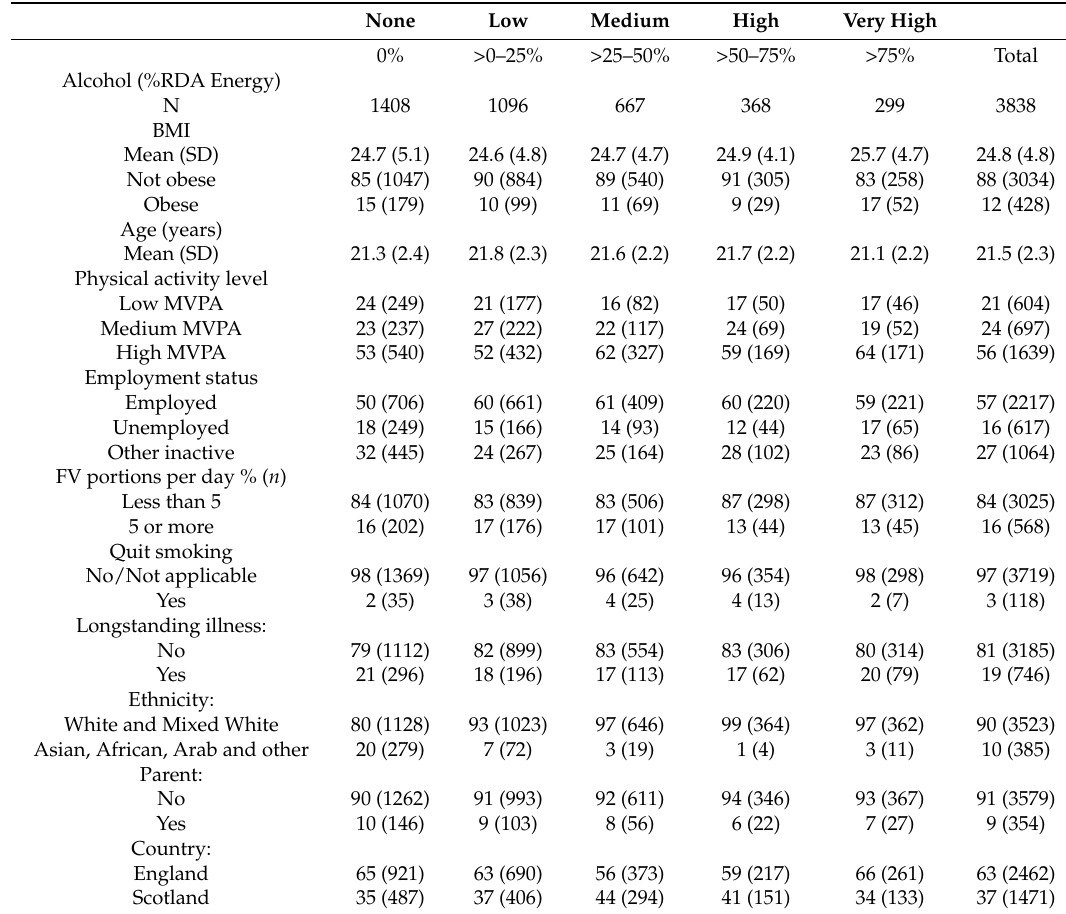
Table 3. Characteristics of the sample from the combined 2008–2014 HSE and SHS survey, by percentage of recommended daily allowance for energy from alcoholic beverages consumed by individuals on their heaviest drinking day (% RDA Energy) for men.